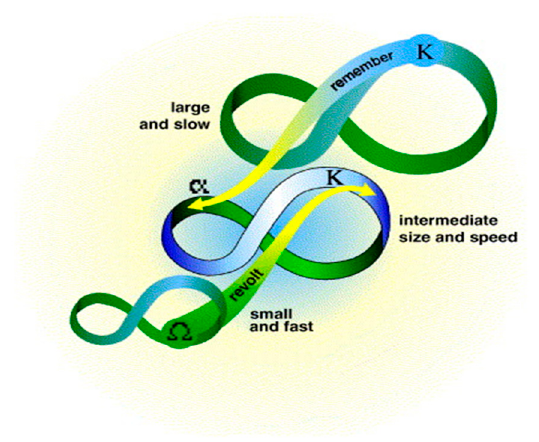
Figure 2. Adaptive cycle in resilience interpretation.